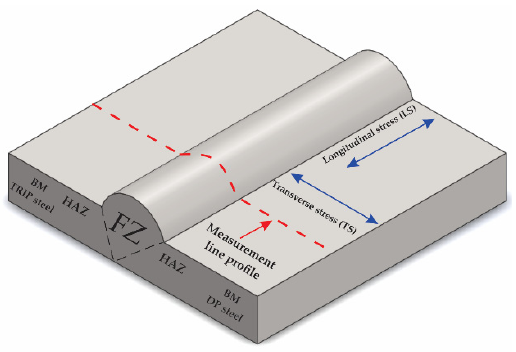
Figure 3. Schematic showing the residual stress measurement path across the